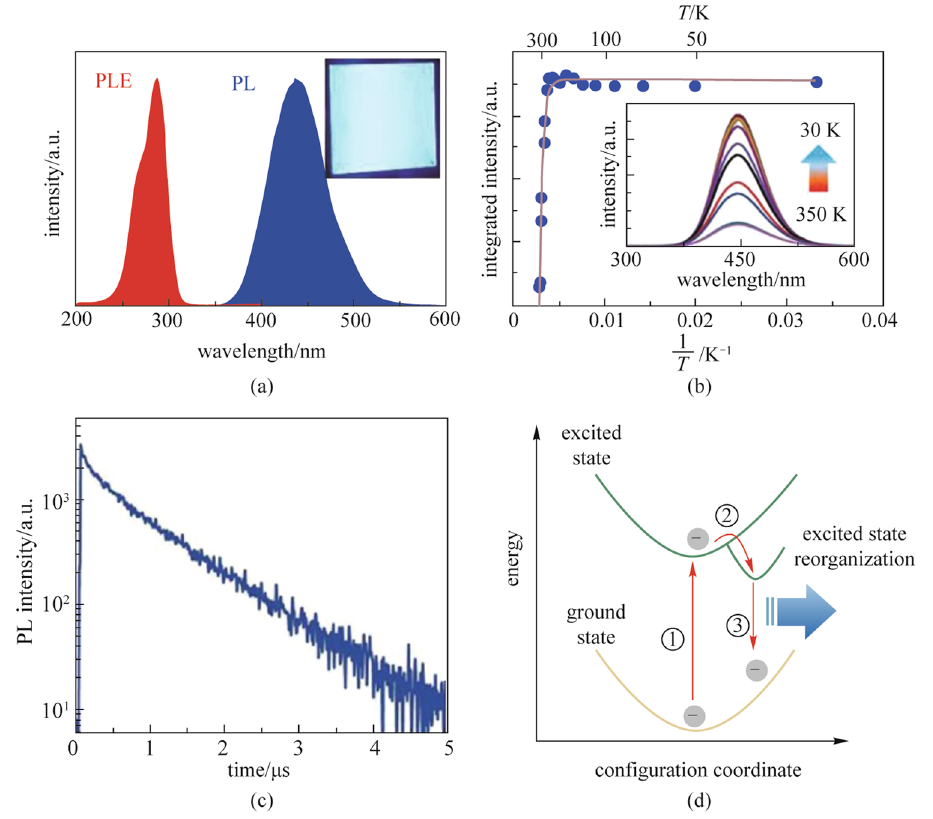
Fig. 4 Optophysical properties of Cs 3 Cu 2 I 5 : a PL and PLE spectrum of the Cs 3 Cu 2 I 5 thin film; b Integrated PL intensity as a function of recip- rocal temperature from 30 to 350 K. The inset of b shows the temperature-dependent PL spectrum; c Time-resolved PL decay curve at room temperature; d Mechanism of configuration coordinate for the excited-state reorganization. Reprinted with permission from Ref. [31], Copyright 2018, WILEY–VCH Verlag